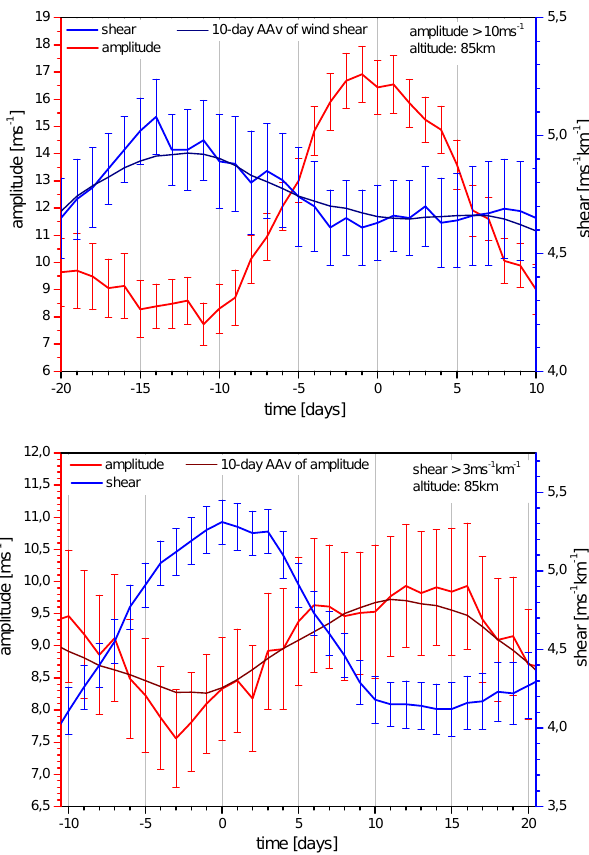
Figure 9. Superposed epoch analysis of vertical wind shear of the zonal prevailing wind in blue and QTDW total amplitudes in red at 85km altitude, including standard error. The 10-day adjacent averages of the amplitude are in dark red and wind shear in dark blue. Upper panel: maxima in wind shear > 3ms − 1 km − 1 are con- sidered as key events. Lower panel: maxima in QTDW amplitude > 10ms − 1 are considered as key events.